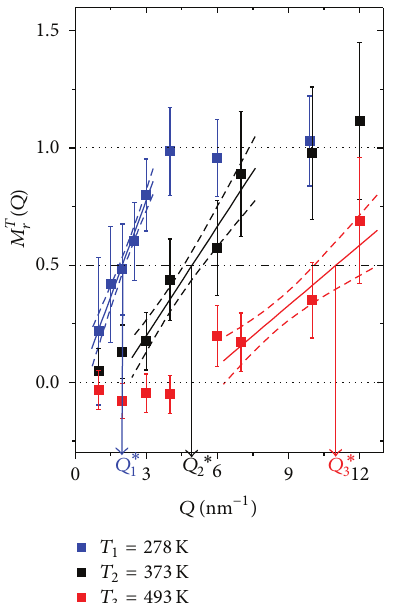
Figure 10: The reduced longitudinal modulus of water measured by IXS [14] as a function of 𝑄 and at the 𝑇 values indicated in the legend. The centers of the viscoelastic crossover 𝑄 ∗ are indicated by horizontal arrows. The straight lines used for the interpolation of the viscoelastic crossover positions are reported (solid lines) together with the curve corresponding to 𝑎 ± 1𝜎 error (dashed line).